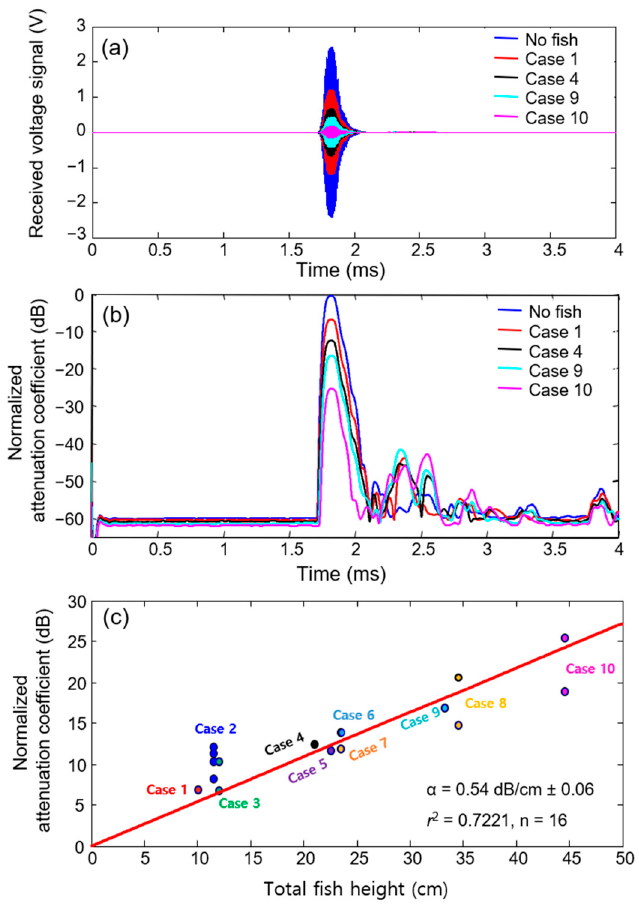
Figure 3. ( a ) Received voltage signal and ( b ) normalized attenuation coefficient ( α ) for no fish, case 1, case 4, case 9, and case 10 experiments from the hydrophone, ( c ) the results of the least square linear regression between the total height of the fish and the normalized attenuation coefficient from the experimental all cases.